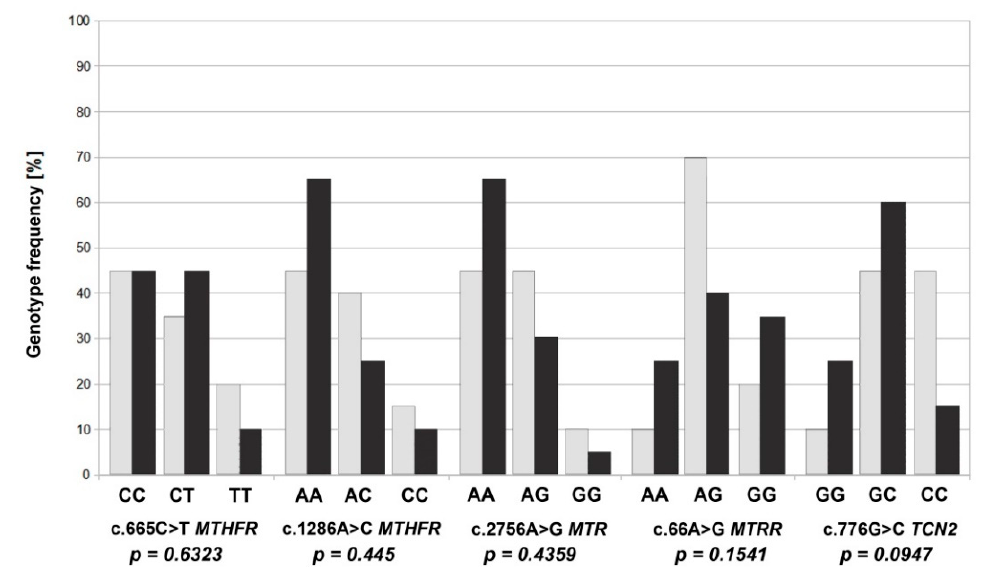
Figure 3. The frequency of the genotypes (homozygous and heterozygous) of selected variants c.665C>T MTHFR , c.1286A>C MTHFR , c.2756A>G MTR , c.66A>G MTRR and c.776G>C TCN2 in the control group (dark bar) and the study group (light bar).